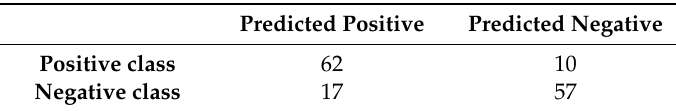
Table 2. Confusion matrix of SVM.